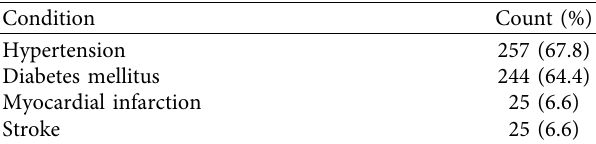
Table 2: History of chronic conditions among the participants.